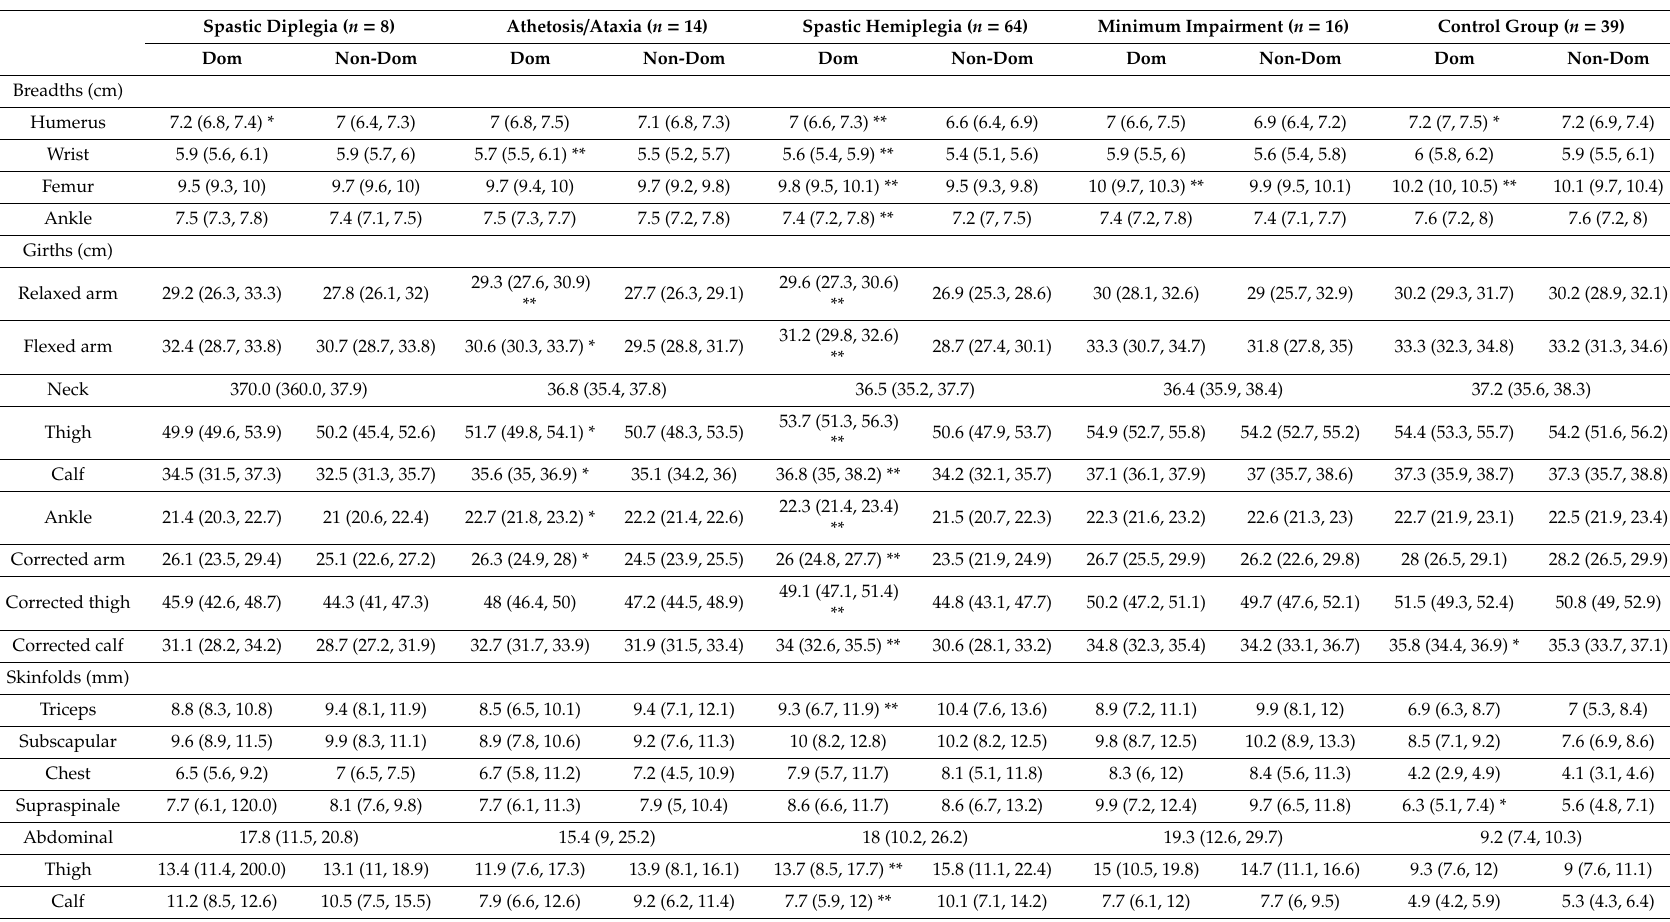
Table 2. Anthropometric measures and body composition of the four CP profiles and the able-bodied football players (control group). Spastic Diplegia ( n = 8) Athetosis / Ataxia ( n = 14) Spastic Hemiplegia ( n = 64) Minimum Impairment ( n = 16) Control Group ( n = 39)